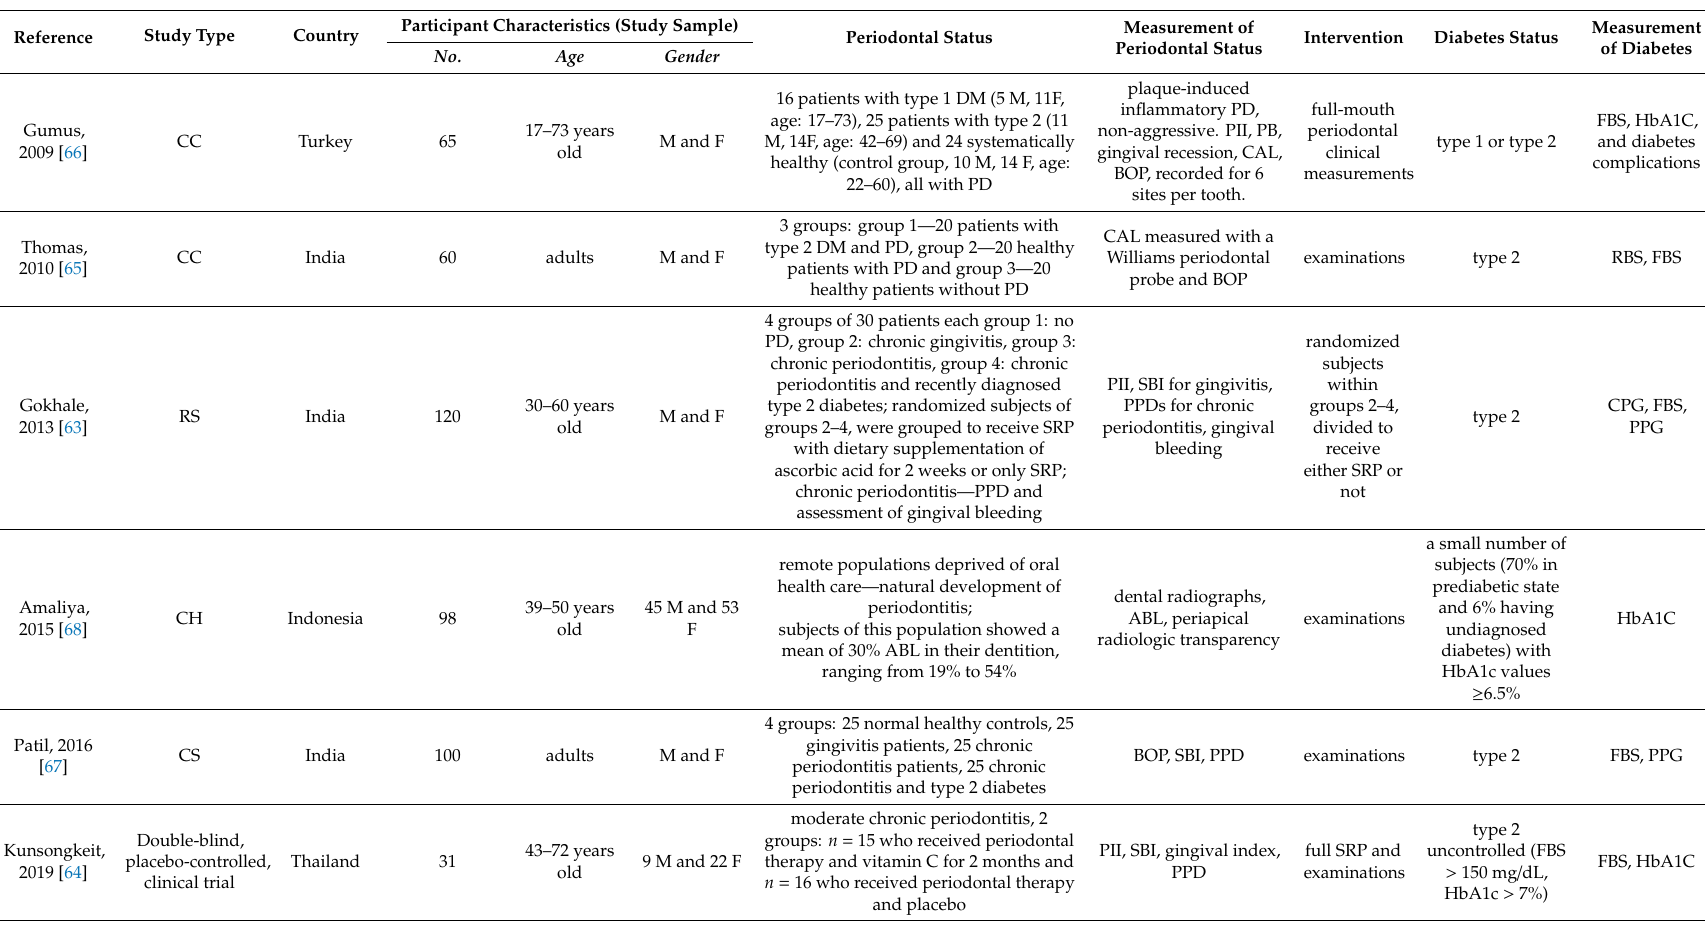
Table 1. General data of the eligible